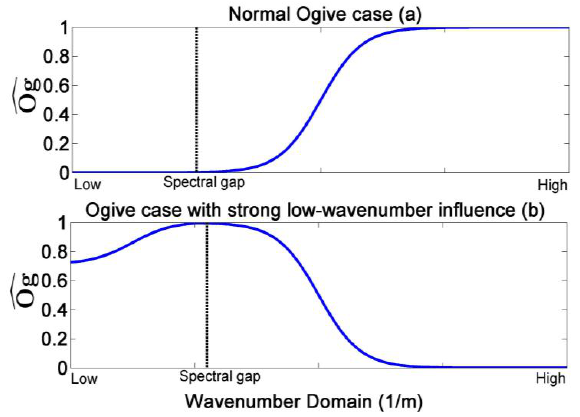
Figure 3. The example diagram of Equation (4) for normal Ogive case ( a ) and extreme Ogive cases with strong influence from low-wavenumber component of turbulence ( b ).